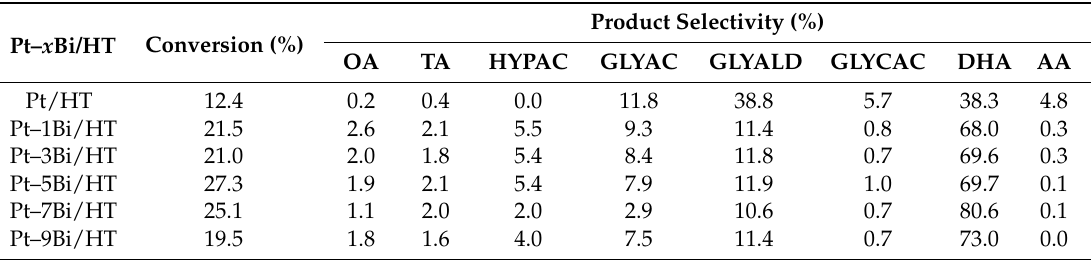
Table 1. Catalytic reaction results on Pt–Bi/HT catalysts with various Bi contents a .